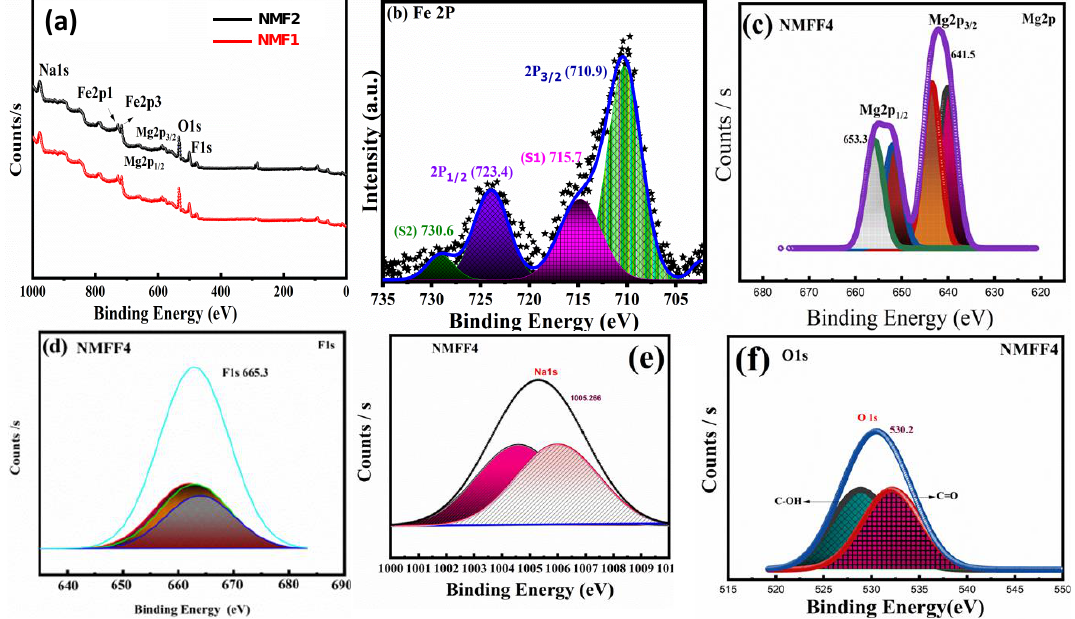
Figure 5. ( a – d ) XPS patterns of NMFF1, NMFF2, NMFF3, and NMFF4. ( e ) Na1s spectra and ( f ) deconvoluted spectrum of oxygen.